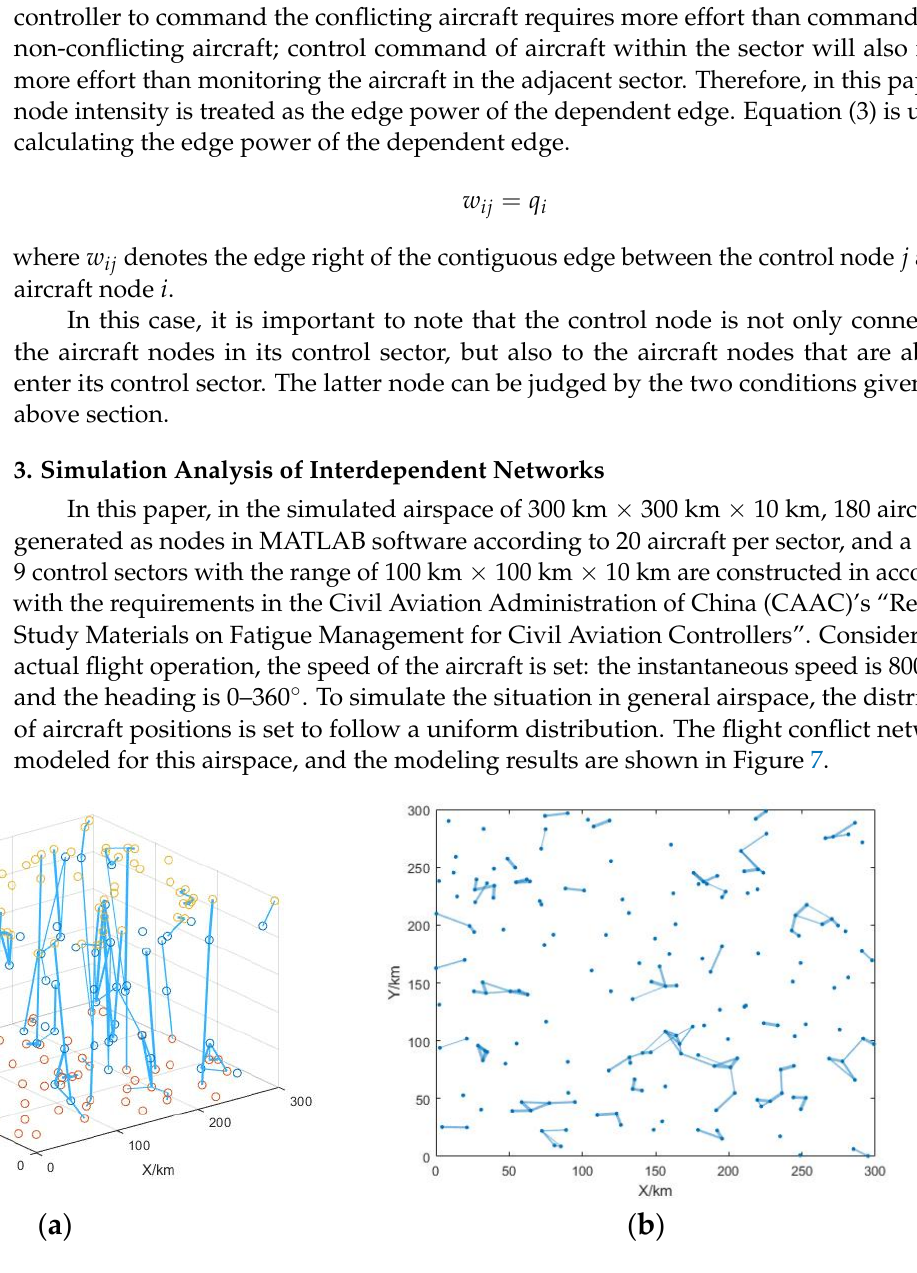
Figure 7. Flight conflict network. ( a ) 3D conflict network diagram. ( b ) Plane conflict network diagram. In Figure ( a ), all three colored circles indicate randomly generated aircraft in the hypothetical airspace. The orange and yellow ones indicate aircraft flying horizontally in the lower and upper boundaries of the airspace. The blue ones indicate aircraft flying in the middle range.